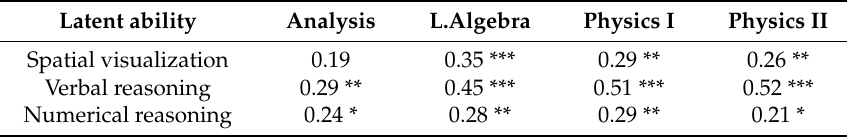
Table 8. Correlations between latent abilities and grades among math-physics students.